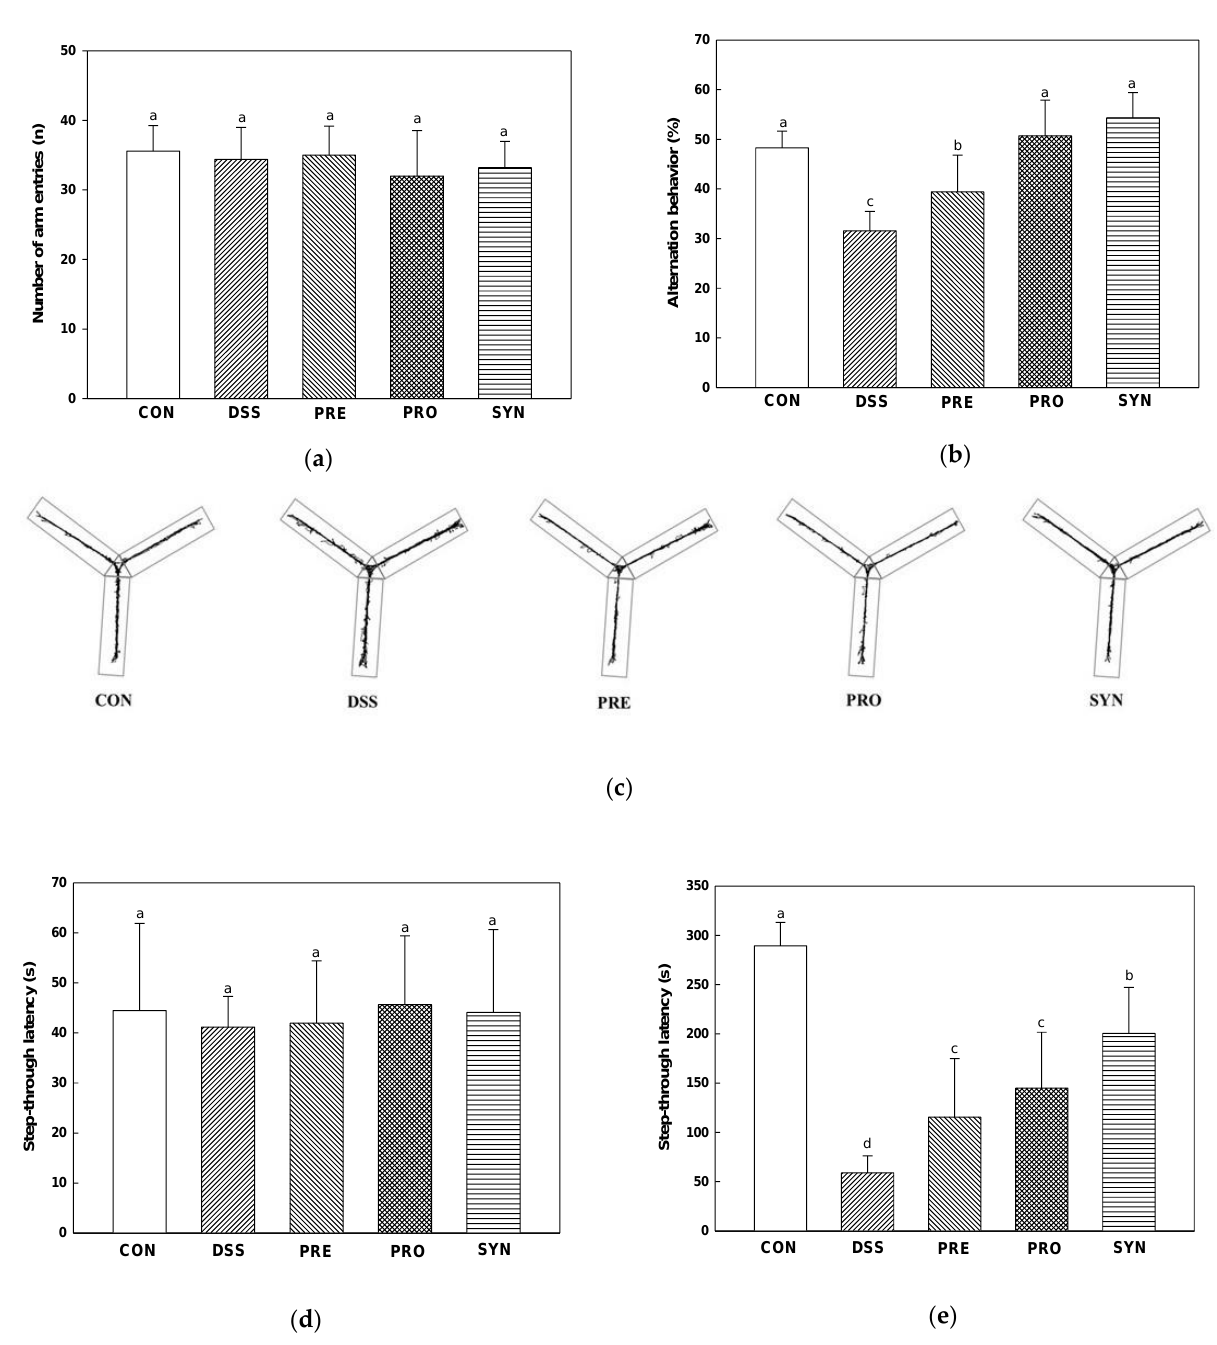
Figure 5. Effects of PRE, PRO, and SYN on learning and memory impairment of DSS-induced colitis